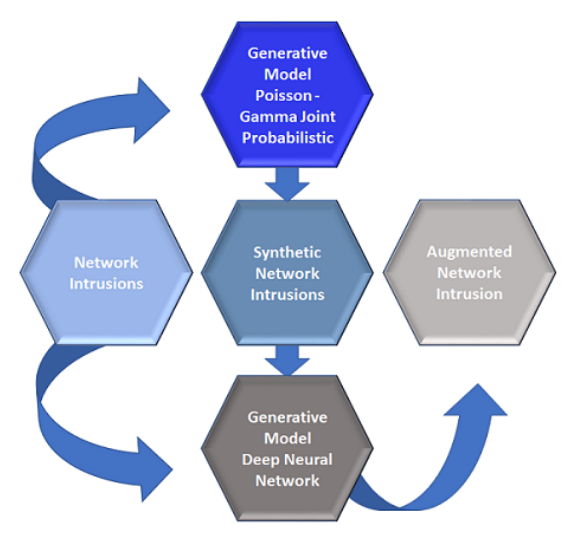
Figure 6. DA Module Structure (Recreated with permission from ref. [33]. Copyright 2022 He